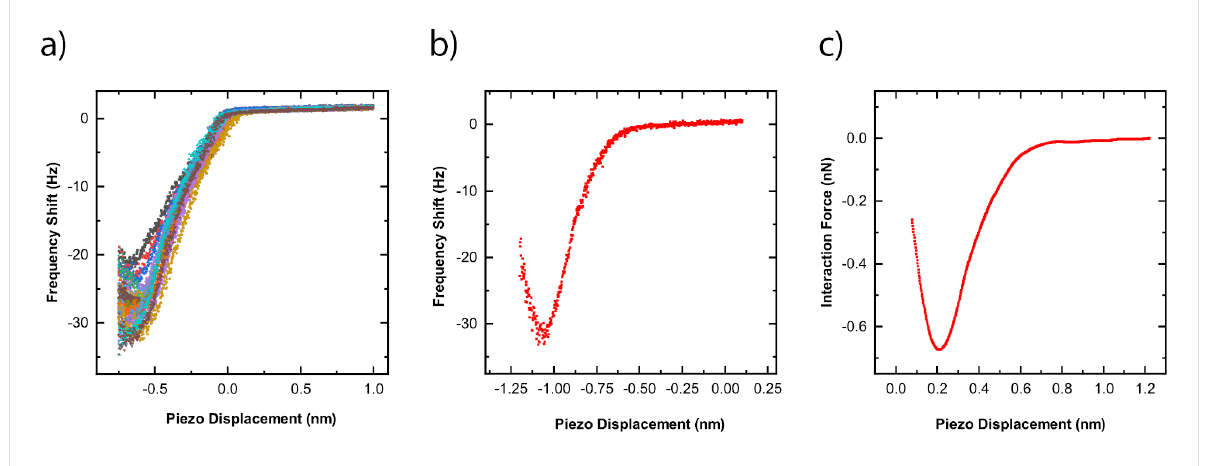
Figure 4: (a) 20 Δ f – d curves measured at one grid position on the diamond sample using a silicon AFM probe. (b) An example of a single Δ f – d curve from the same grid position as in Figure 5a. (c) The corresponding calculated interaction force from Figure 5b, as calculated via the method de- veloped by Sader and Jarvis